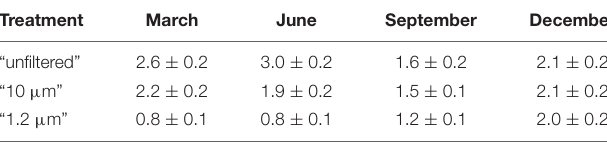
TABLE 3 | Median of the total phosphorus [ µ M] with the standard error for all treatments during the experiments.